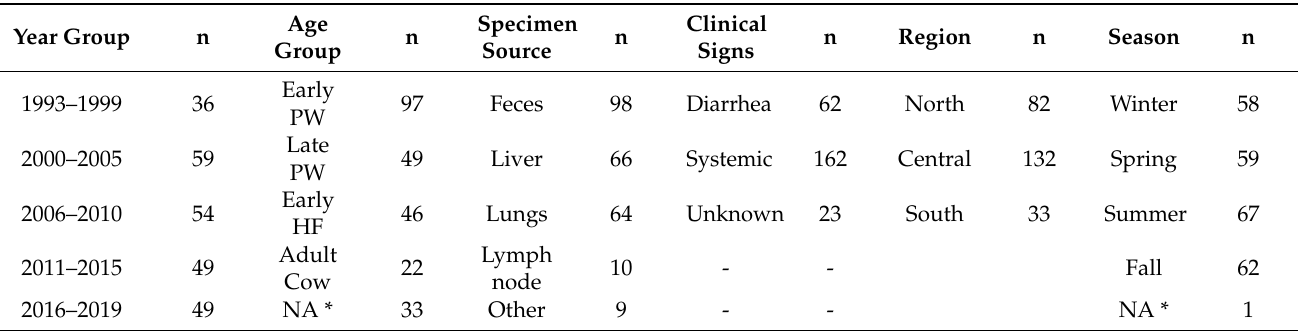
Table 1. Distribution of isolates by response variables year group, age group, specimen source, clinical signs, region and season.